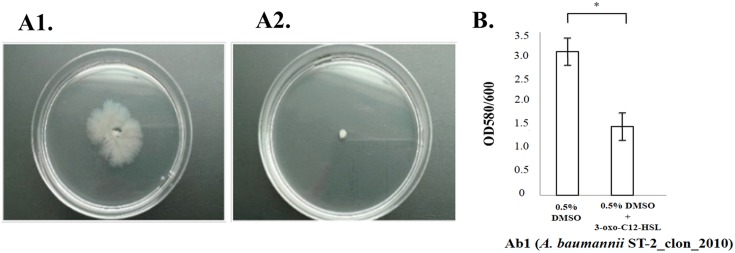
The figure shows inhibition of motility (A2) and biofilm formation (B) in Ab1 in the presence of 3-oxo-C12-HSL (QQ activity). As a negative control, motility and biofilm formation in Ab1 were studied in the presence of 0.3% dimethyl sulfoxide (DMSO), which is a solvent for 3-oxo-C12-HSL (A1 and B).